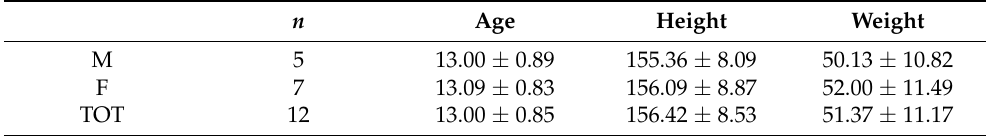
Table 1. Characteristics of the